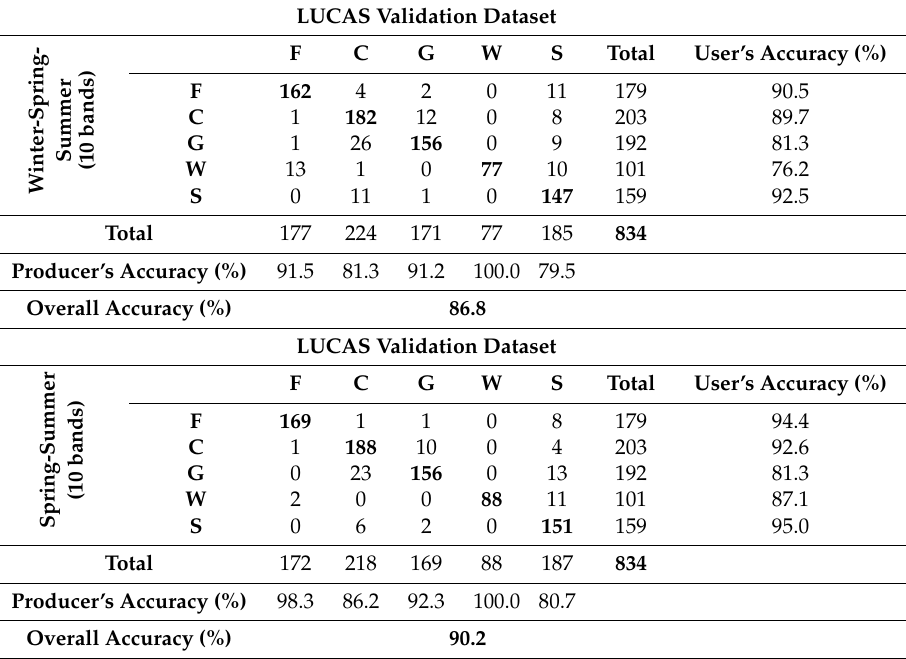
LUCAS Validation Dataset